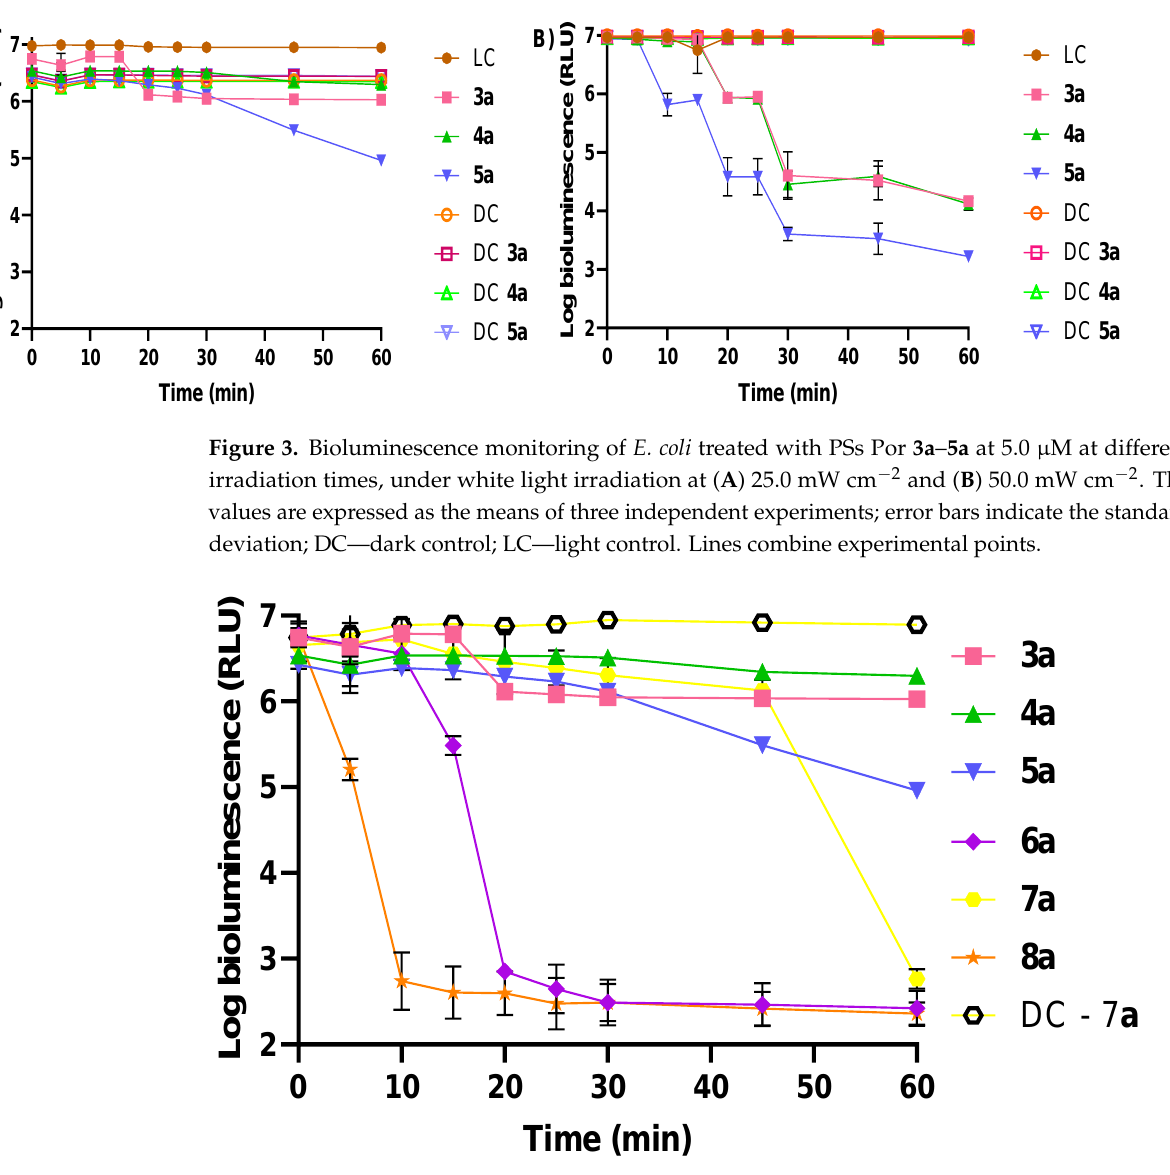
Figure 4. Comparison of photoinactivation of bioluminescent E. coli treated with methoxypyridinium Pors 3a – 5a and thiopyridinium Pors 6a – 8a* at 5.0 µ M at different irradiation times, under white light irradiation at 25.0 mW cm − 2 . Values are expressed as means of three independent experiments; error bars indicate standard deviation. * The results for Pors 6a and 8a were described in the article [17]. For a better consistency in our study, it was related to the reduction in E. coli bio- luminescence with the reduction expressed in log 10 CFU mL − 1 accomplished with the pour-plate methodology at times 0 and 60 min. The obtained results are presented as the average of the three assays in Figure 5. The obtained results for the Por–CD derivatives 3a – 5a confirmed the results obtained through the bioluminescence monitoring of the PDI treatment. Only the conjugate 5a was able to generate a decrease of ~1.5 log (ANOVA, p < 0.0001) in the viability of E. coli after 60 min of light irradiation. Besides, at the same irradiance (25 mW cm − 2 ) and light exposure time (60 min), the Por–CD 7a caused a total photoinactivation of the E. coli , which corroborated the determined bioluminescence results, and is similar to the PDI results found in the literature for Por–CD 6a and 8a 17 ). When the irradiance was increased to 50 mW cm − 2 , Pors 3a – 5a caused a decrease of ~2 log 10 to ~4 log 10 in the viability of E. coli , and Por 7a reached a complete bacteria inactivation. These results are in agreement with the RLU results found for photoinactivation